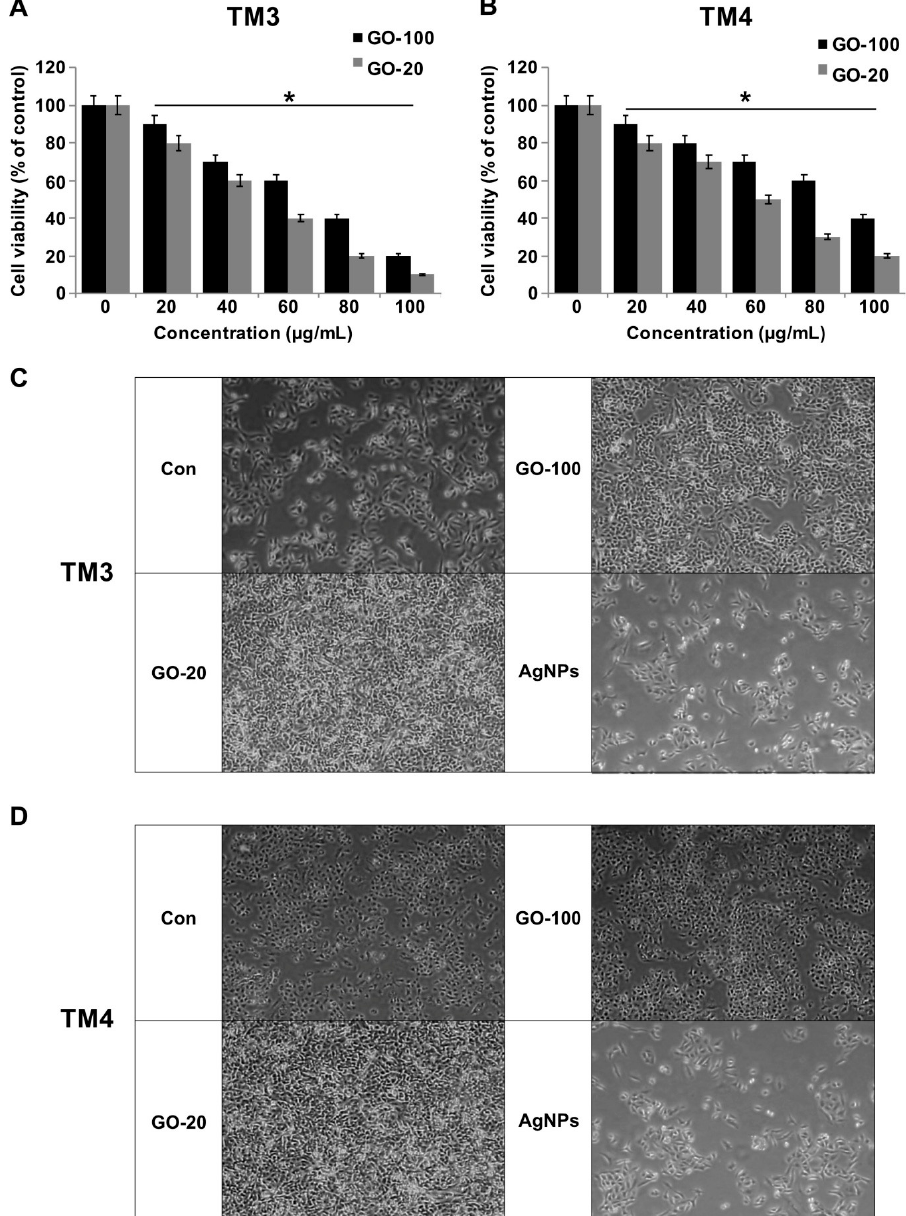
Figure 2. GO-100 and GO-20 graphene sheets inhibit viability of TM3 and TM4 cells. ( A ) The viability of TM3 cells was determined after 24 h exposure to different concentrations of GO-100 (20–100 µ g/mL) and GO-20 (20–100 μ g/mL), and ( B ) the viability of TM4 cells was determined after 24 h exposure to different concentrations of GO-100 (20–100 μ g/mL) and GO-20 (20–100 μ g/mL) using the CCK-8 assay. ( C ) Cell morphology of TM3 was assessed under a light microscope. ( D ) Cell morphology of TM4 was assessed under a light microscope. The results are expressed as the mean ± standard deviation of three independent experiments. At least three independent experiments were performed for each sample. The treated groups showed statistically significant differences from the control group by Student’s t -test (* p < 0.05). Scale bar 200 µ